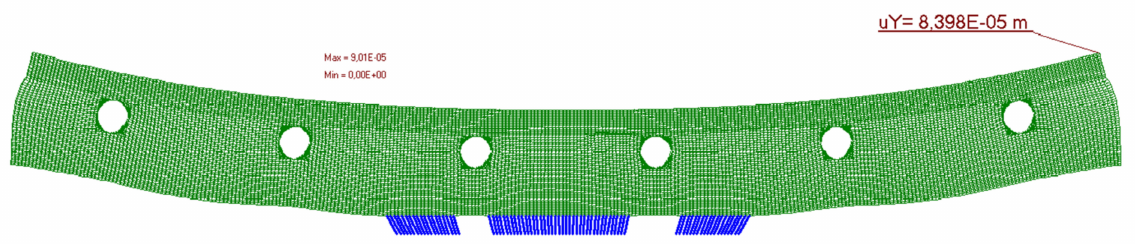
Figure 19. Deformation of the